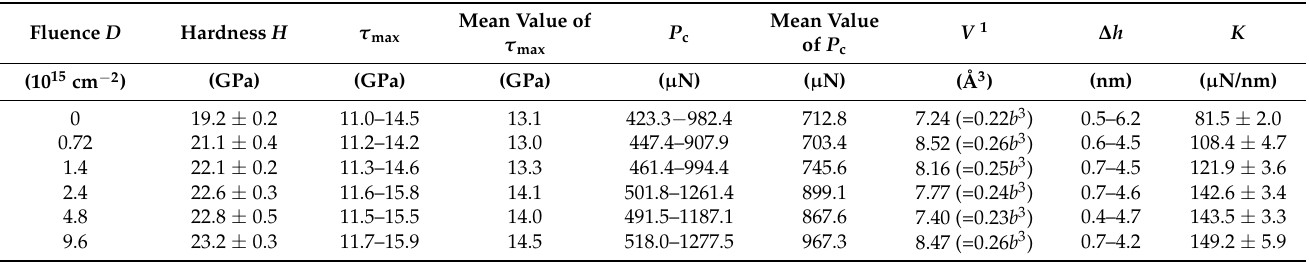
Table 1. Measured mechanical and physical properties of unirradiated and irradiated GaN single crystals by nanoindentation.